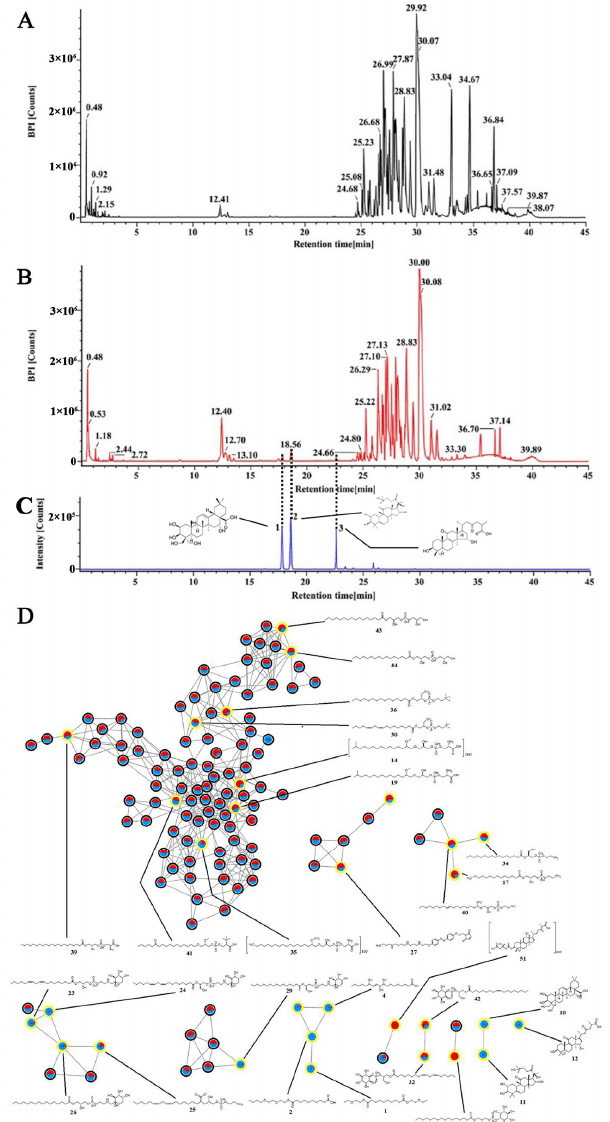
Figure 6. OUPLC–Q–TOF/MS chromatograms and annotation of the molecular networking. ( A ) OUPLC–Q–TOF/MS chromatograms of rice. ( B ) UPLC–Q–TOF/MS chromatograms of G42. ( C ) Three unique triterpenoids components in G42. The compound 1 is platycodigenin, reserve time is 17.80 ± 0.1, the molecular weight is C 30 H 48 O 7 , and the molecular weight is 520.3400. The compound 2 is cucurbitacin IIb, reserve time is 18.56 ± 0.1, the molecular weight is C 30 H 48 O 7 , and the molecular weight is 520.3400. The compound 3 is ganolucidic acid B, reserve time is 22.59 ± 0.1, the molecular weight is C 30 H 46 O 6 , and the molecular weight is 502.3294. ( D ) Molecular network of the tested samples, in which red represents components of the rice extract, blue represents components of the G42 extract, and yellow represents significantly varied components. The area of different colors represents the relative content of node components in different